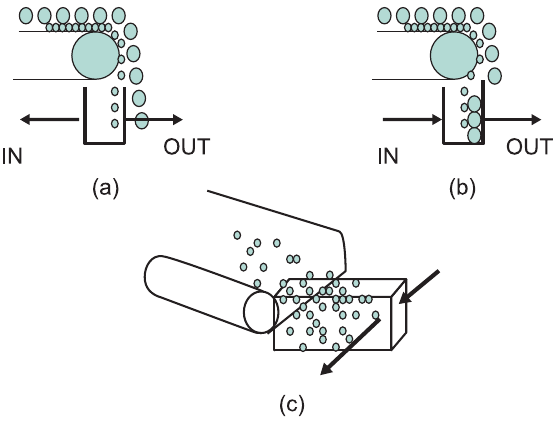
Fig. 8 A schematic drawing explaining the reasons for good and bad sampling techniques. (Courtesy of Reg Davies,